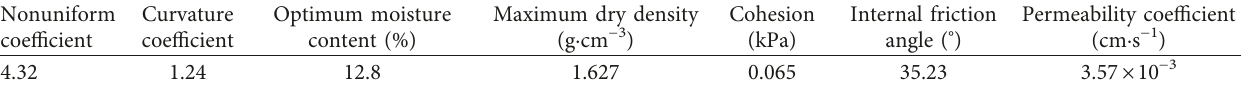
Table 1: The basic property indexes of aeolian